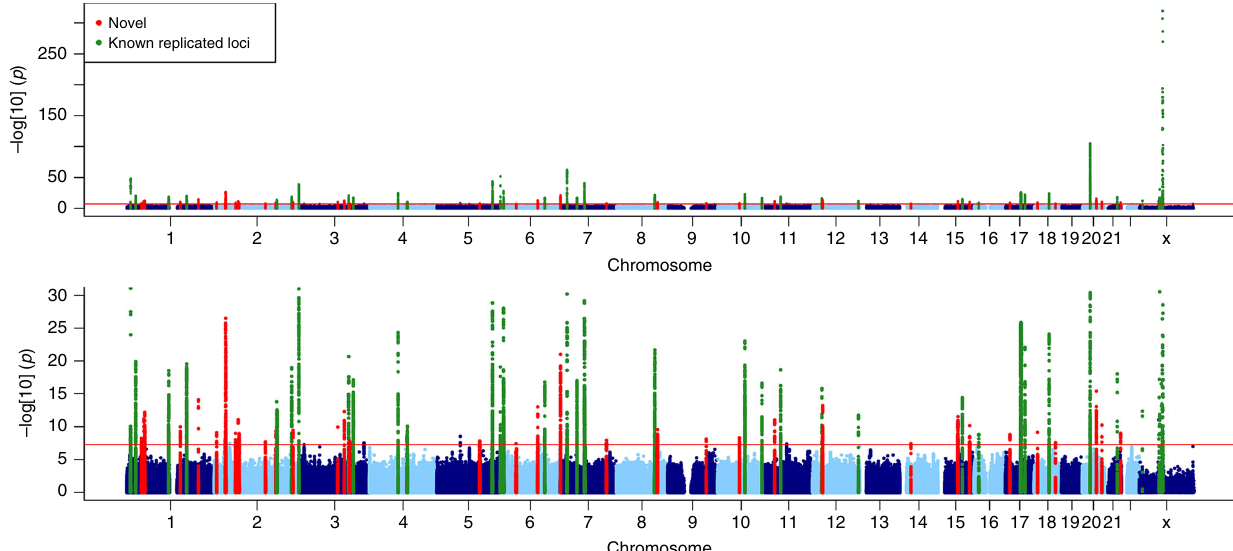
Fig. 1 Manhattan plots of the discovery phase association analysis. In the lower panel, the p values have been capped at 1 × 10 − 30 to aid legibility. Loci have been coloured in red if novel, orange if reported but not replicated and green if known and